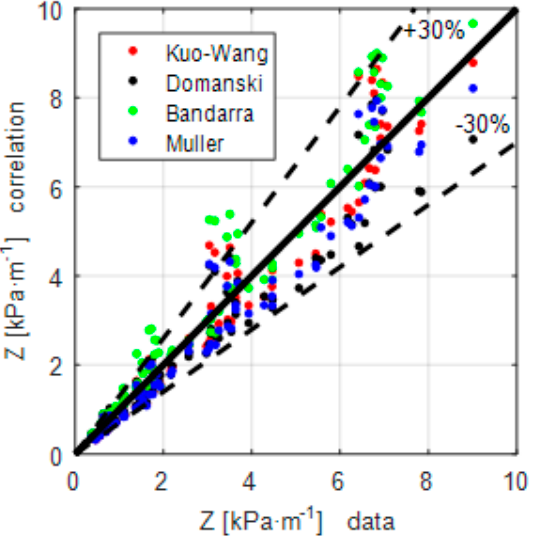
Figure 8. Comparison between the experimental data and the best performing correlations developed for the pressure drop per unit length.